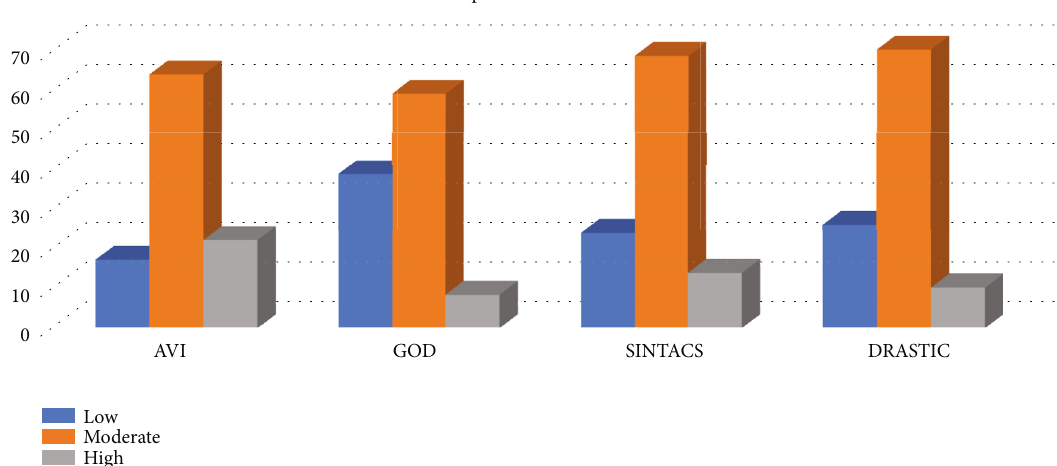
Figure 13: Histogram showing the comparison of the areas between the vulnerability classes.